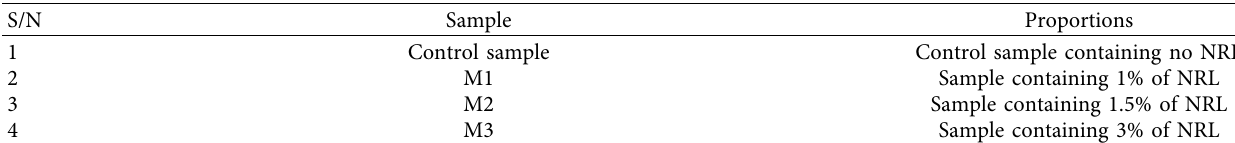
Table 3: Sample labelling.